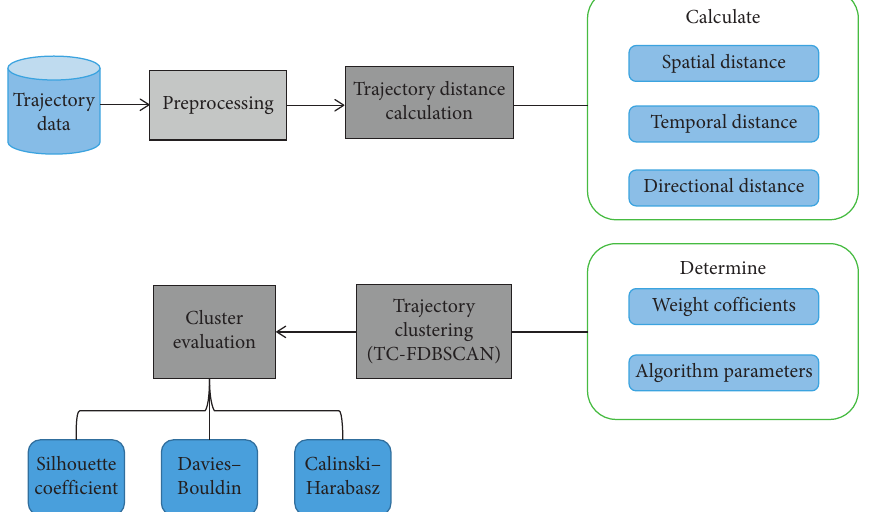
Figure 1: Framework of the trajectory clustering